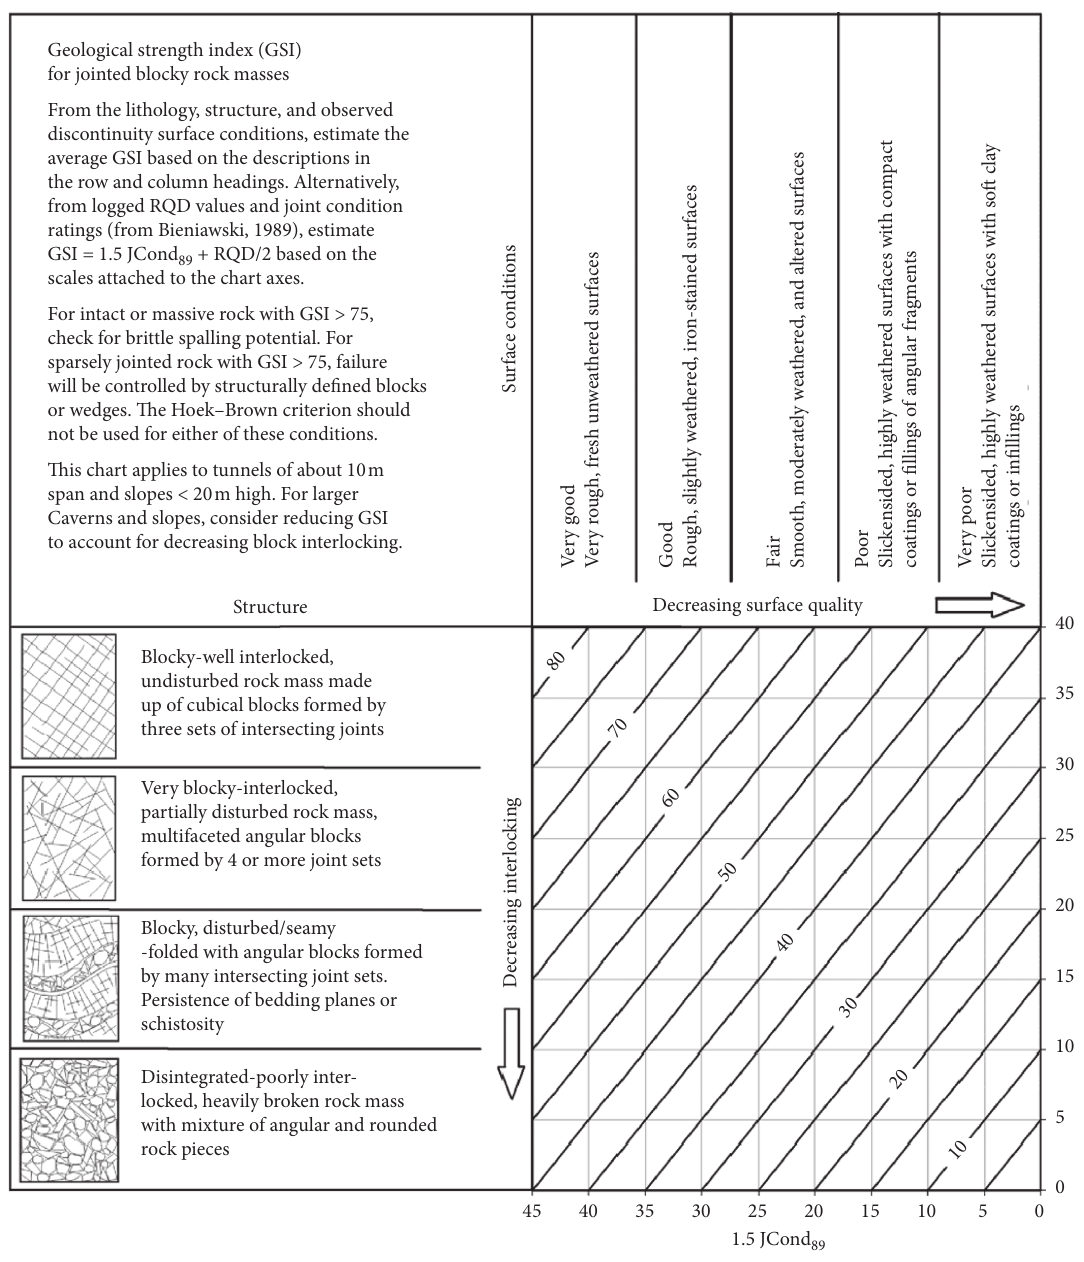
Figure 9: GSI showing scale A represented by 1.5 JCond